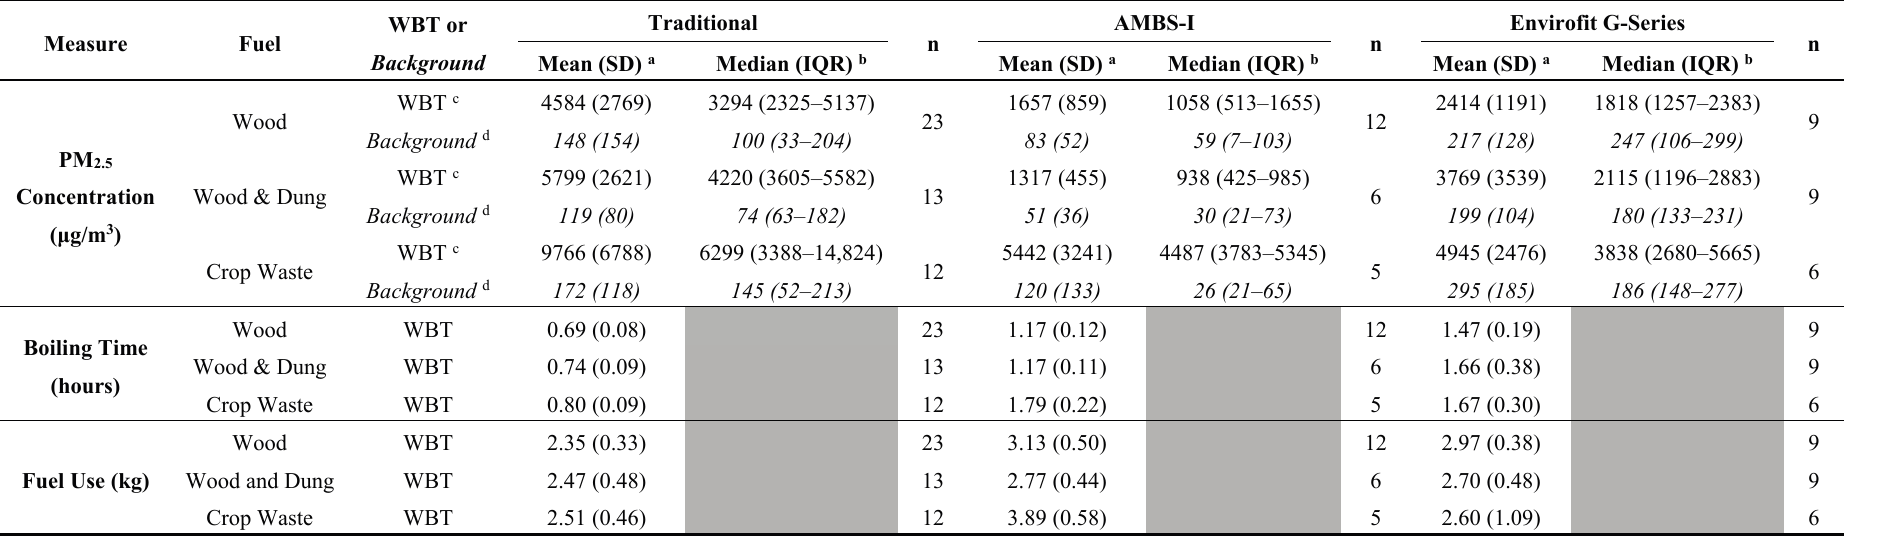
Table 2. Summary of cookstove performance in Study I comparing two alternative cookstoves to a traditional stove in a home setting in rural Nepal